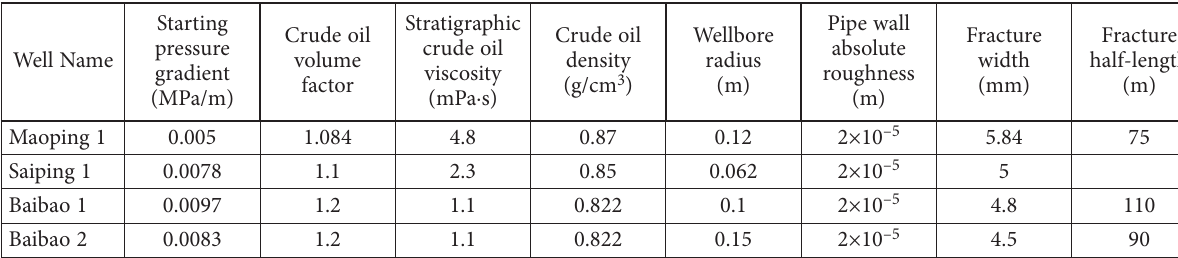
Table 2. Other wells parameters